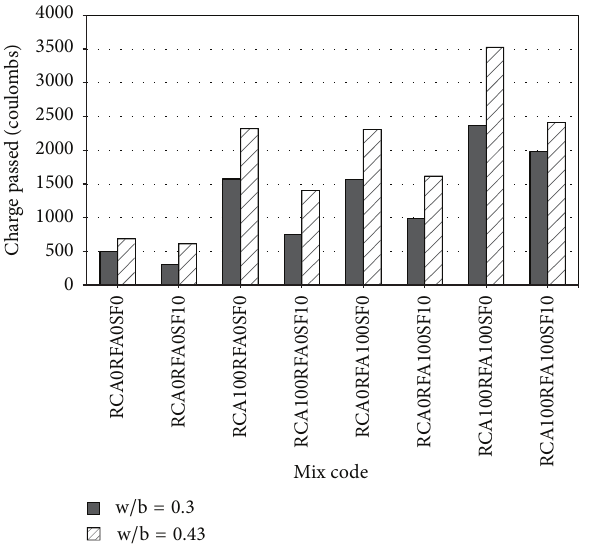
Figure 8: RCPT test results of SCCs at 56 days.